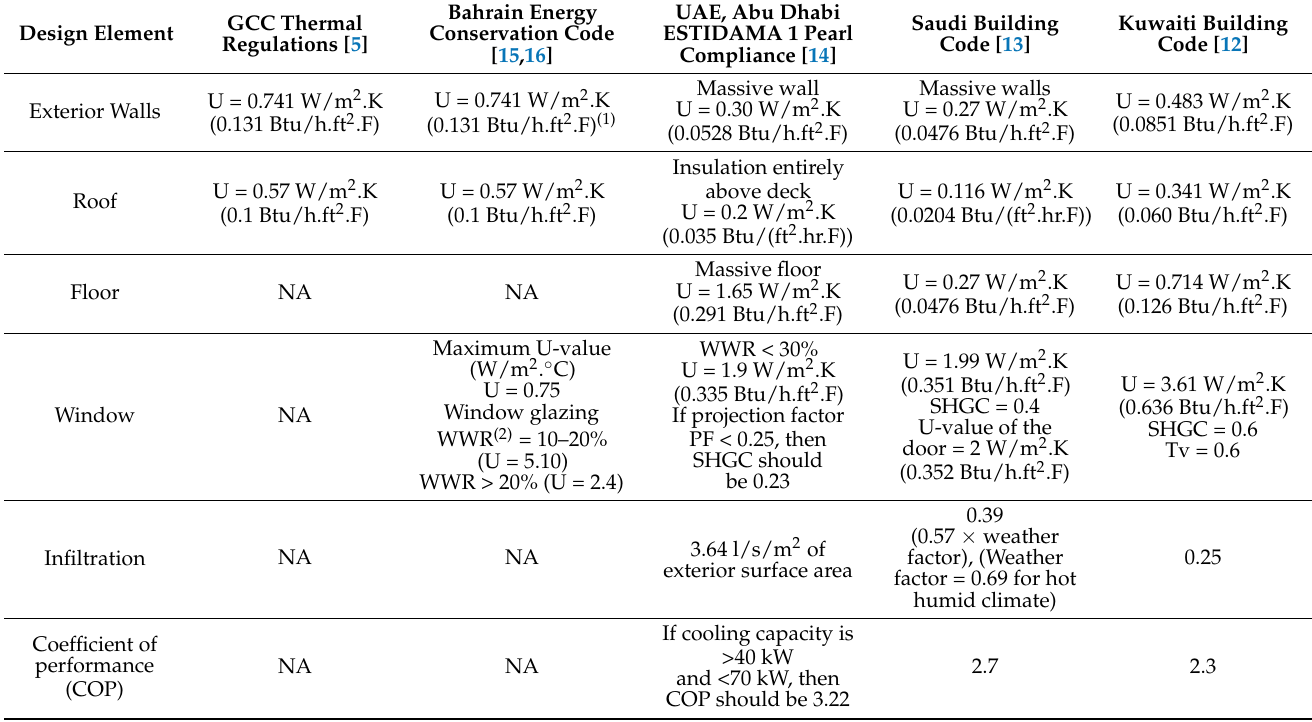
Table 1. Minimum requirements for code compliance in residential buildings for different GCC countries adapted from